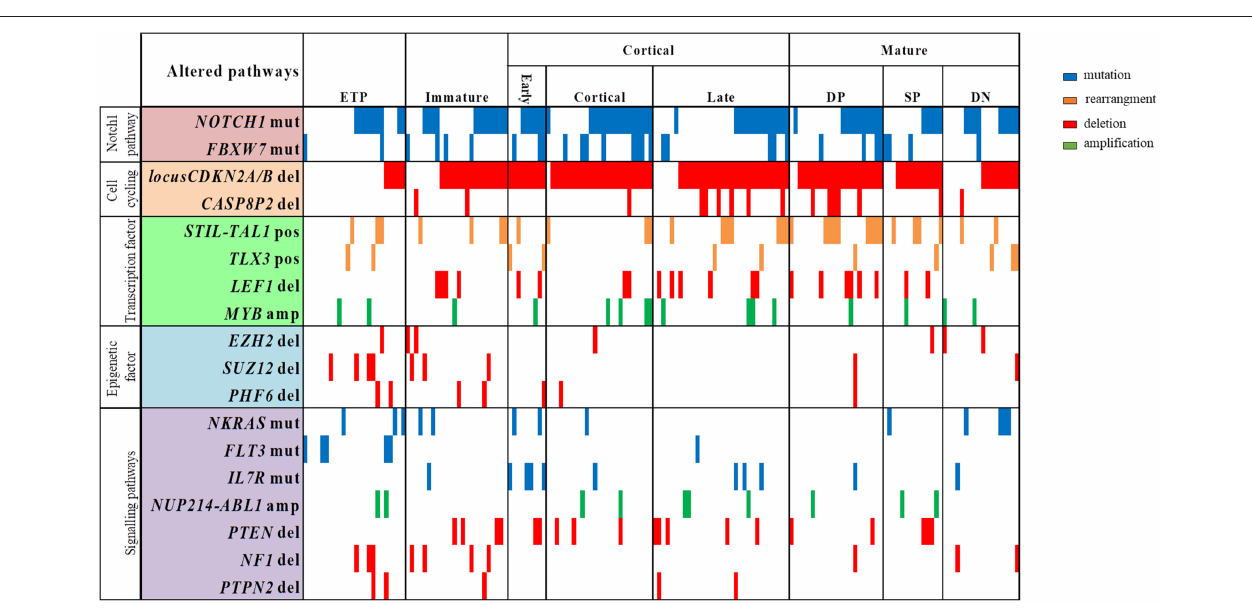
FIGURE 1 | The frequencies and the concomitance of molecular alterations in 168 pediatric T-ALL cases. (A) Circos plot showing the overall co-occurrence of mutations, rearrangements, and CNA assessed through MLPA. Outer segments proportionally represent the alterations found in T-ALL. Interior lines connecting the outer segments proportionally demonstrate the concomitances among genetic alterations. (B) Number of cases with each molecular alteration in gray squares, and number of cases with concomitances between two alterations in white, green and red squares. Green squares represent positive while the red squares negative associations. Alterations ordered by type of abnormality. Rearrangements in blue, mutations in pink, CNA deletions in brown and amplifications in yellow.